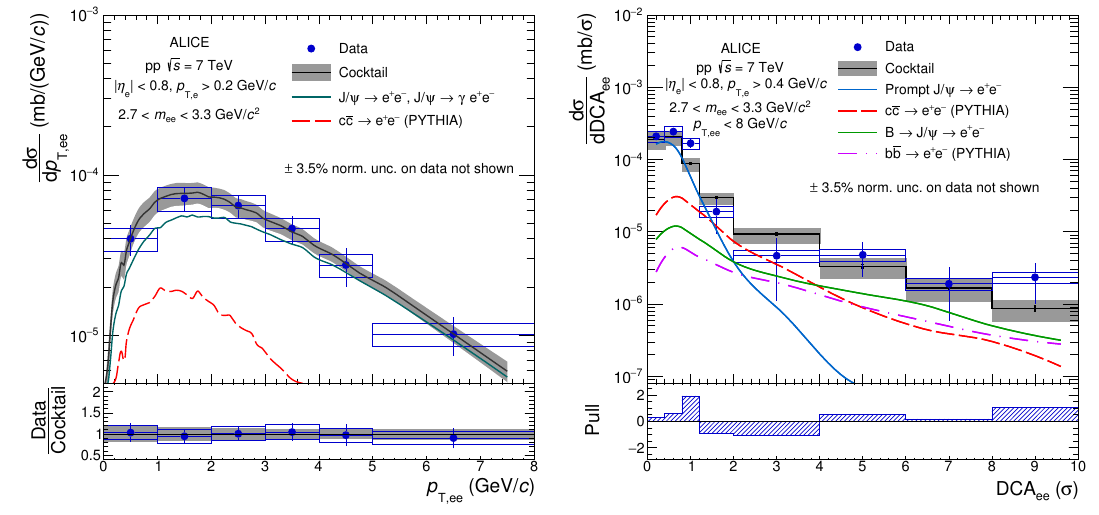
p s = 7 TeV in the